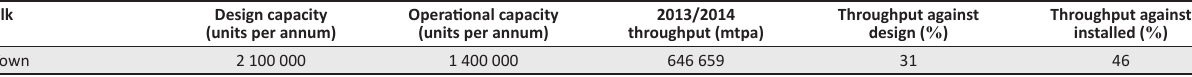
TABLE 1: Throughput against design capacity for dry bulk (2013). Dry